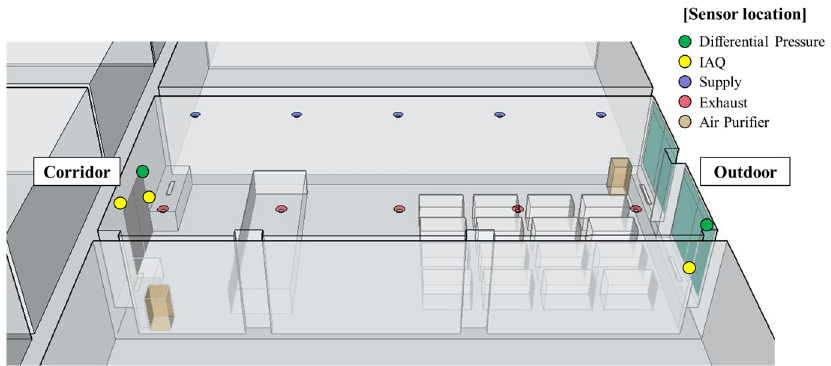
Figure 3. The sensor locations in the living-lab.